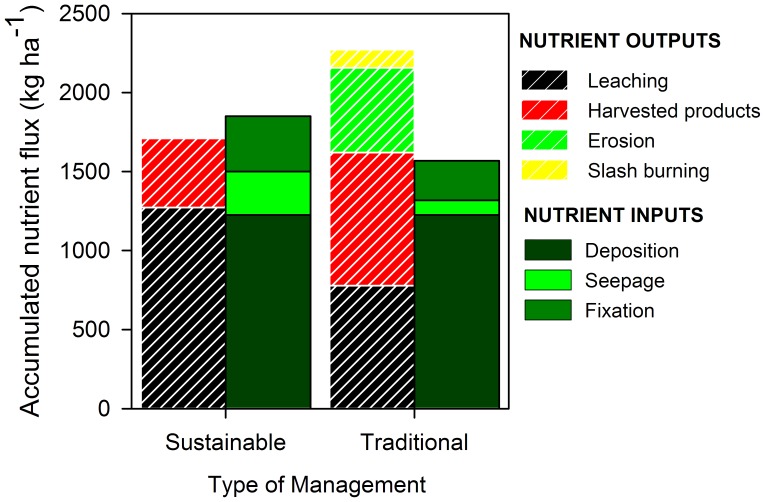
Accumulated N inputs (solid bars) and outputs (dashed bars) in Chinese subtropical plantations after 240 years of management under two most typical management regimes for traditional and sustainable plantations.